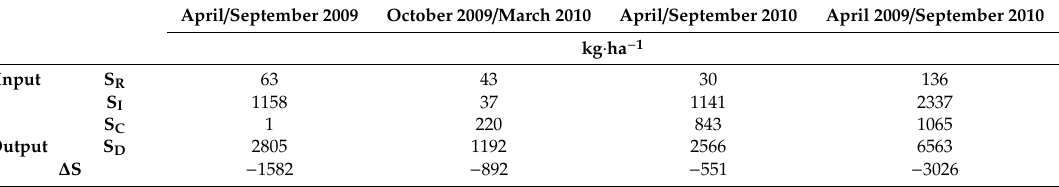
Table 3. Salt balance: salt input [in rainfall (S R ), irrigation (S I ), and in water from Terreu canal discharge (S C )], salt output [in drainage (S D ),] and increase in salt ( ∆ S) in the irrigated lands in Clamor Vieja